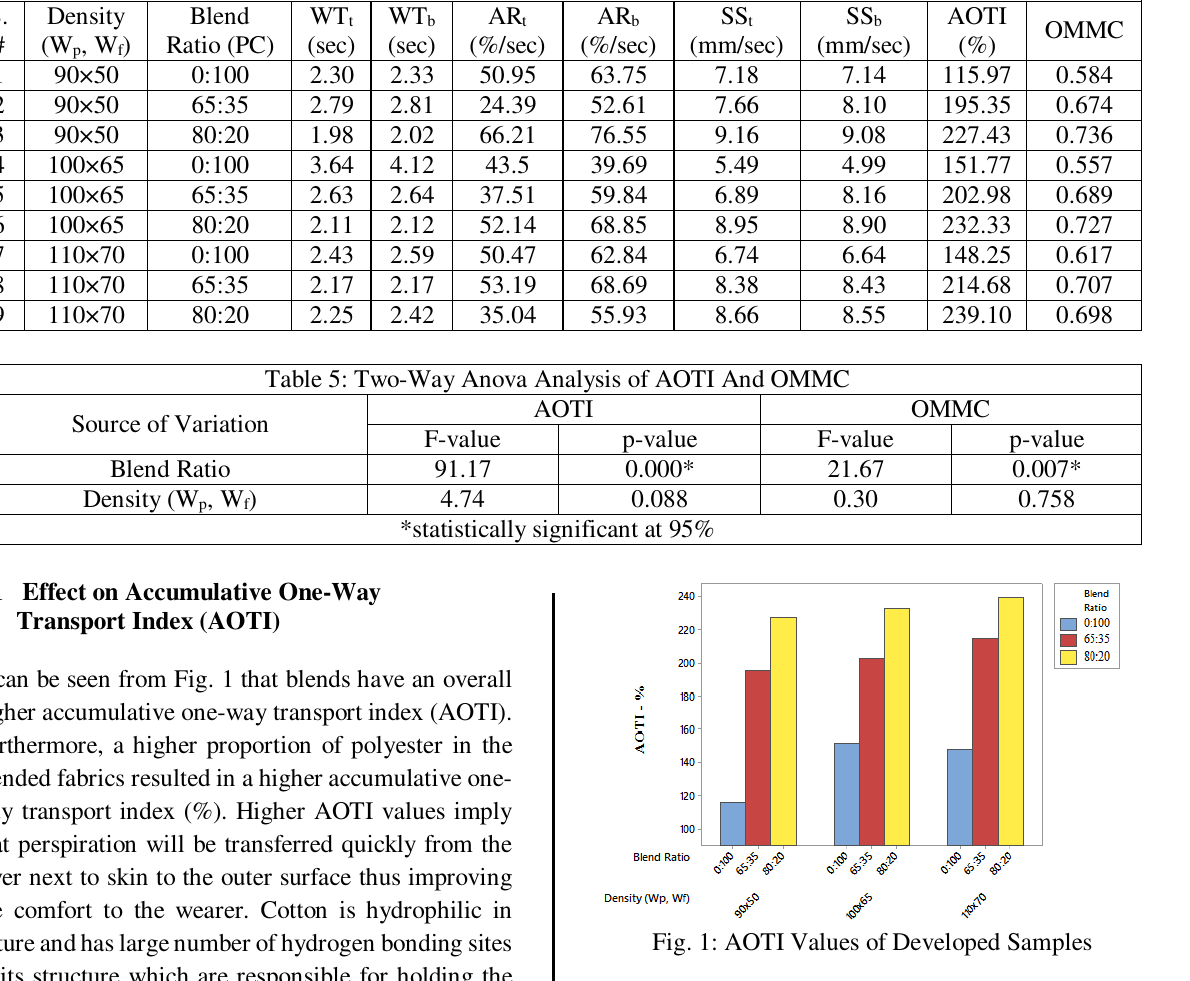
Table 4: Moisture Transport Properties of Developed Samples